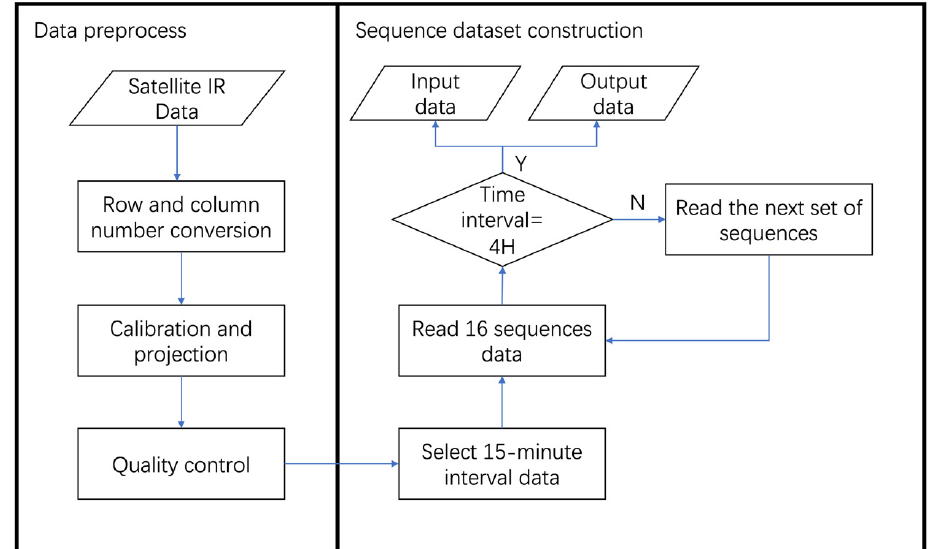
Figure 2. The preprocessing flow of the